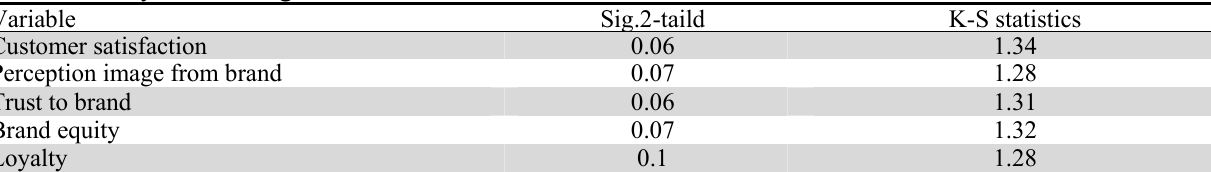
The summary of Kolmogorov–Smirnov test